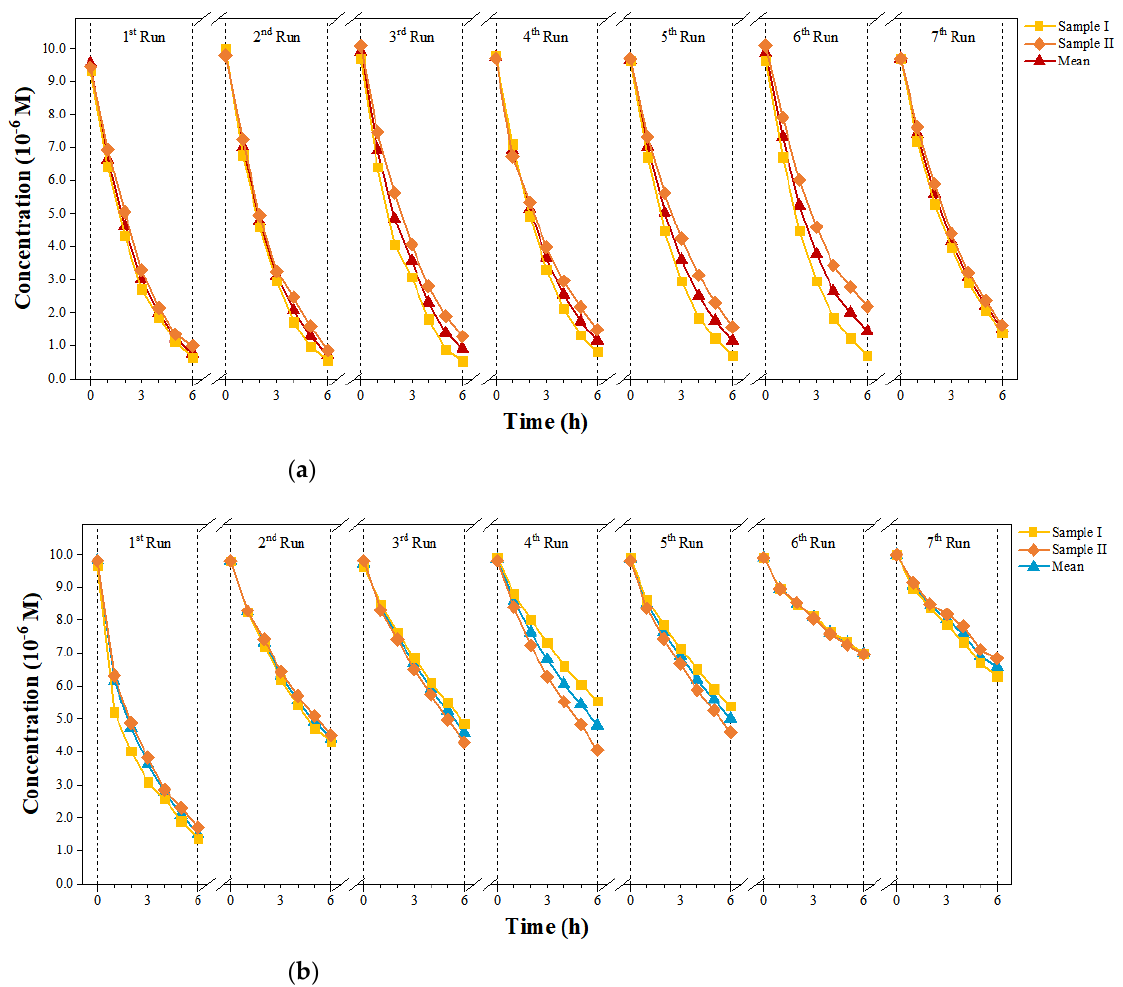
Figure 8. ( a ) Concentration – time curves for two different annealed samples and its average over seven runs; ( b ) concentration – time curves for two different nonannealed samples and its average over seven runs.